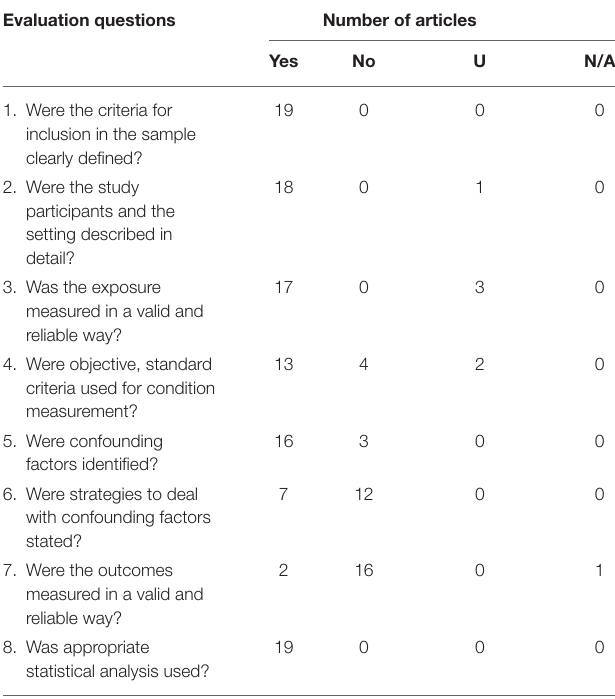
TABLE 1A | Summary of critical evaluation of reviewed studies of cross-sectional design with questions ( n =